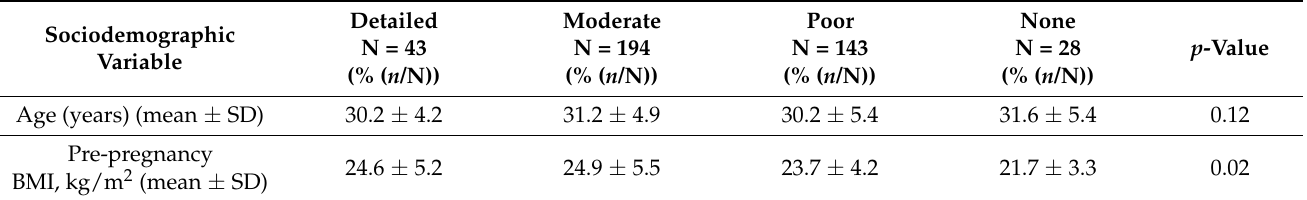
Table 2. GDM knowledge level in relation to age and BMI of